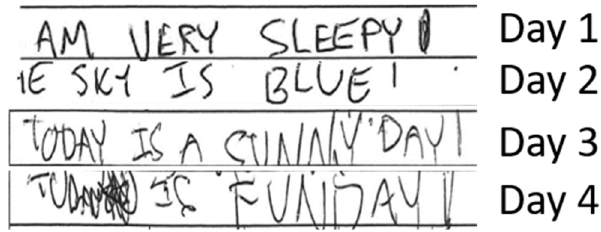
Figure 5. A timeline depicting changes in handwriting since CAR-T cell infusion .